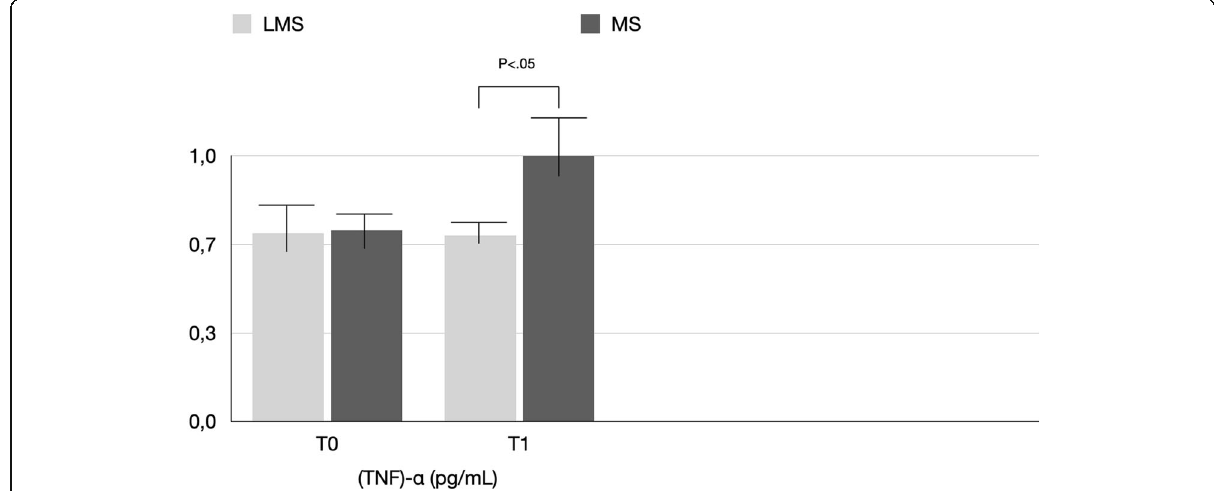
Fig. 7 Comparison of the level of tumor necrosis factor (TNF)- α (pg/mL) detected in LMS and